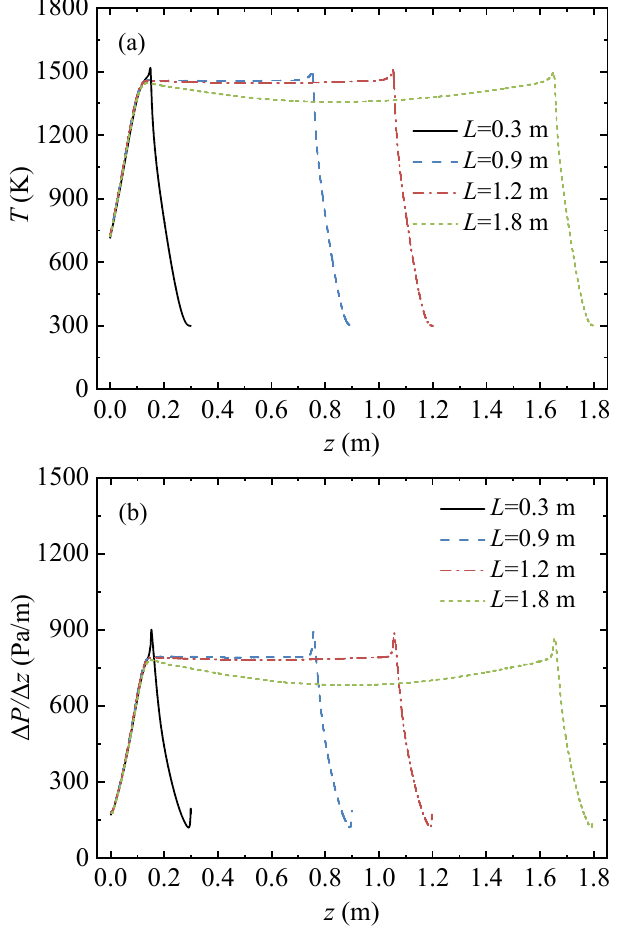
Figure 5. Gas temperature and pressure gradient profiles along the arial direction in the conduit, with various conduit lengths: ( a ) gas temperature profiles and ( b ) pressure gradient profiles.